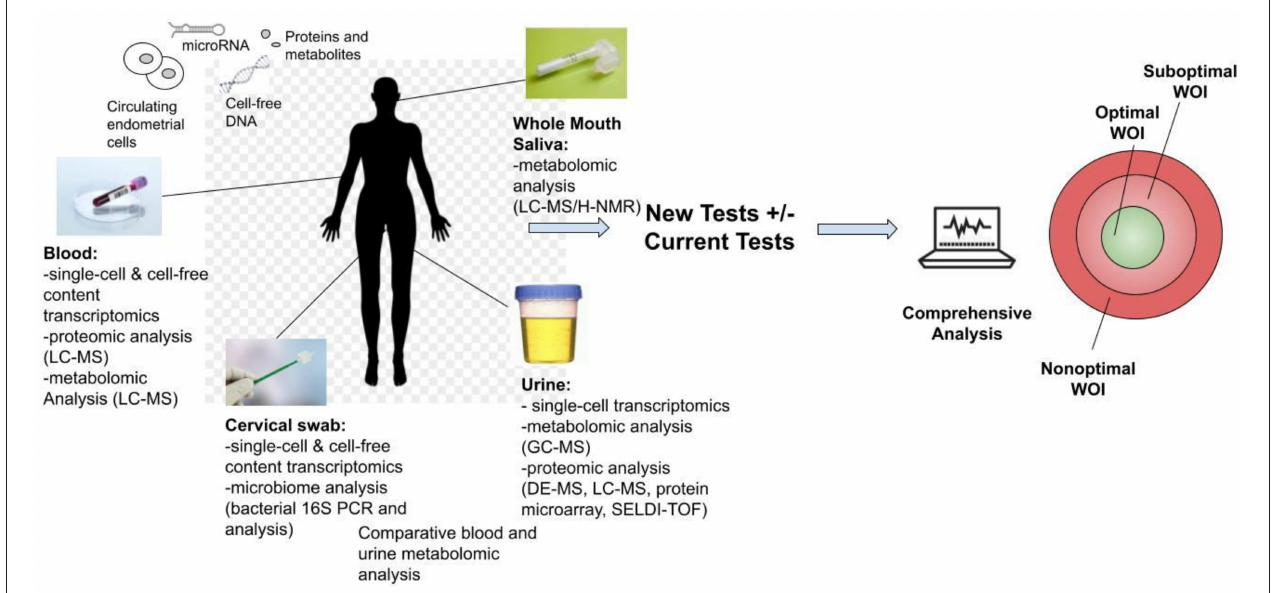
FIGURE 4 | Development of non-invasive tests for the optimal window of implantation (WOI). Multiple analyses could be performed including transcriptomic, metabolomic, proteomic and microbiome profiling through routine saliva, urine, blood or cervical swab tests. The proposed tests above are all currently technically feasible and could be developed into commercial tests. These tests offer the opportunity for advancing the understanding of the biological basis of the endometrial receptivity during the WOI. They also encourage future biomarker discovery, validation and integration of the biomarkers of WOI into daily clinical practice for testing of women of reproductive age to improve pregnancy